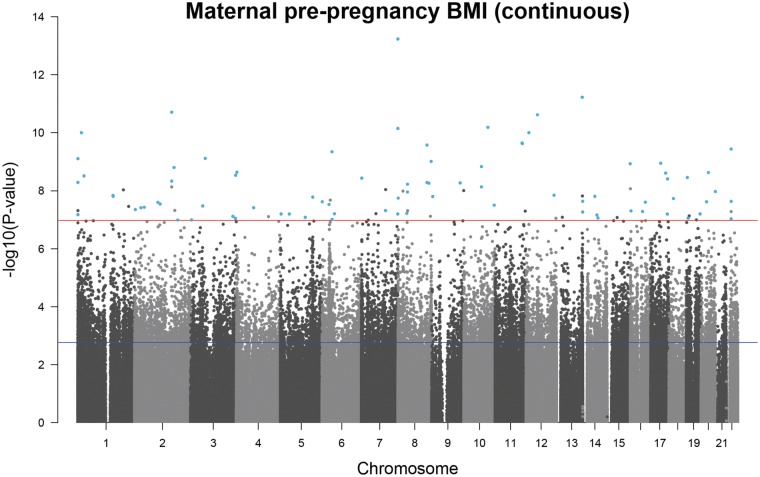
A Manhattan plot for the meta-analysis of associations between maternal pre-pregnancy BMI and offspring DNA methylation at birth after adjustment for maternal covariates and estimated cell counts. The red line shows the Bonferroni threshold for multiple testing. Methylation sites that surpassed the Bonferroni-correction threshold (P < 1.06 × 10−7) before and after adjustment for estimated cell counts are highlighted in blue.